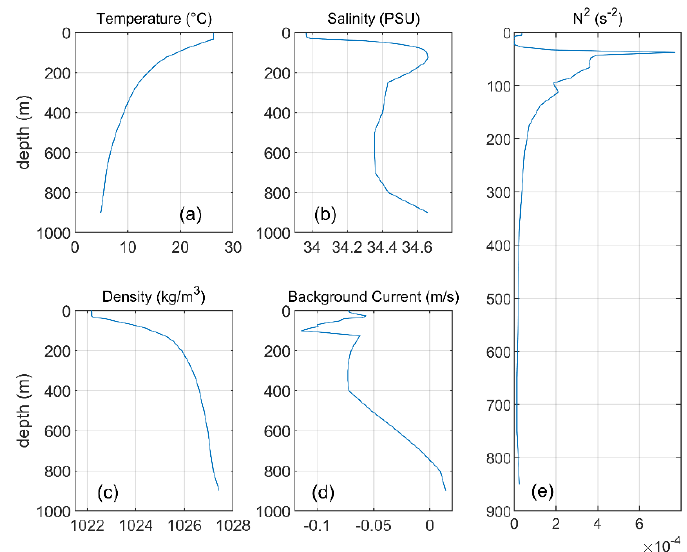
Figure 5. The background physical properties of the HYbrid Coordinate Ocean Model (HYCOM) product. ( a – e ) Temperature, salinity, density calculated, background current, and Brunt–Väisälä frequency N 2 .